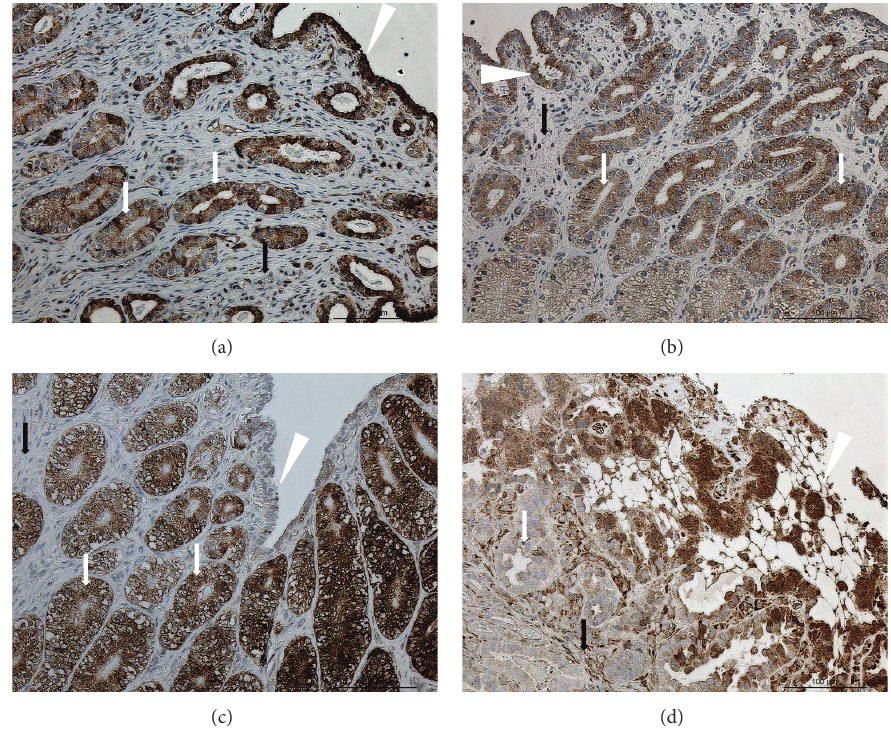
Figure 7: TNFR2 protein localization in endometria. Immunohistochemical (IHC) localization of TNFR2 in the endometria of cats collected at (a) estrus phase (E, 𝑛 = 7 ) and (b) diestrus phase (D, 𝑛 = 8 ) from (c) cats that had been treated with a P 4 derivative analog, medroxyprogesterone acetate (MPA, 𝑛 = 5 ); or (d) cats presenting the clinical symptoms of pyometra (PYO; 𝑛 = 3 ). In females at (a) estrus and (b) diestrus, TNFR2 expression is localized in the glandular and surface epithelium; (c) in MPA females, very strong signals are observed in the endometrial glands, whereas (d) in PYO females, strong signals are present in surface and glandular epithelium and weaker ones in endometrial stroma. Surface epithelium: white arrowheads; glandular epithelium: white arrows; endometrial stroma: black arrows.